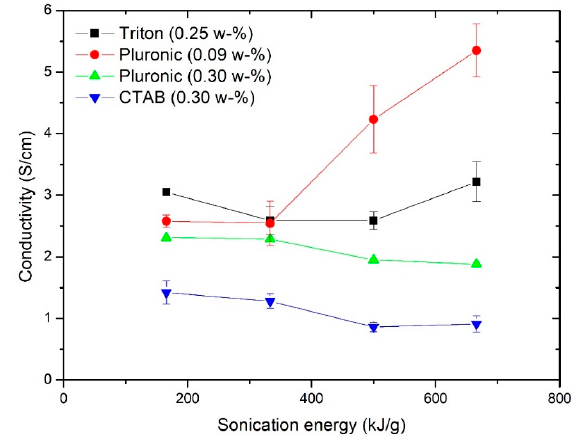
Figure 1. Conductivity of nanocomposite films processed using surfactants Triton X-100, Pluronic F-127 and cetyl trimethylammonium bromide. Concentration in weight percentages.